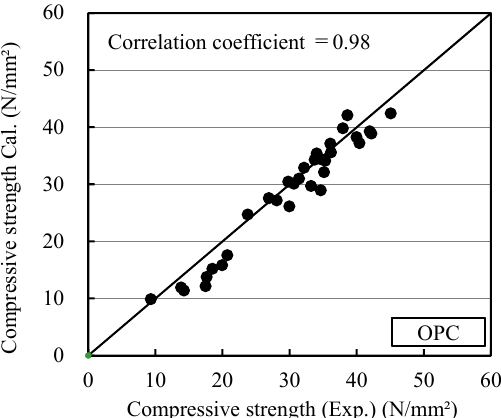
Figure 11. Measured compressive strength and calculated compressive strength (OPC): Proposal equation for this study.